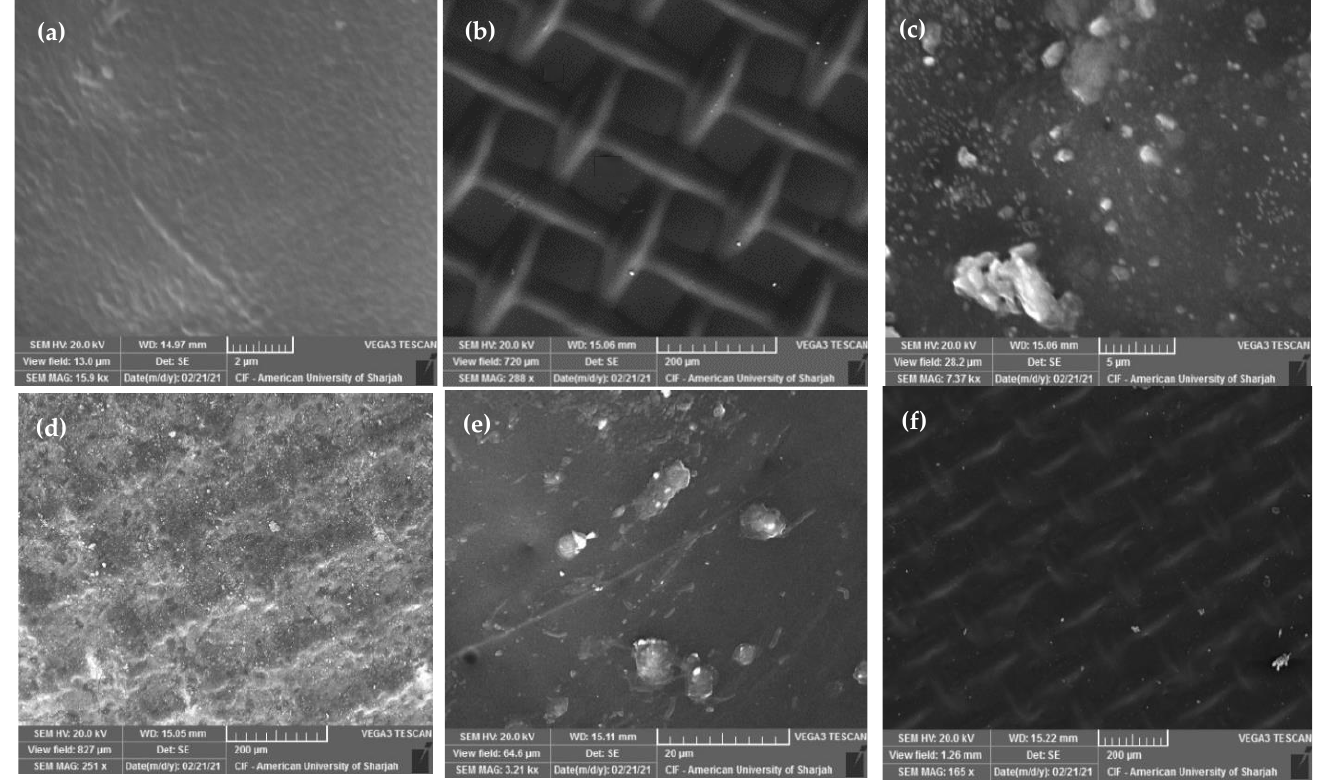
Figure 4. SEM images of the original membrane ( a ) active layer and ( b ) support layer, the membrane after use for the ( c ) active layer and ( d ) support layer at low CFV with the ultrasound facing the support layer (Case 0.25-CC-SL with NaCl draw solution), and the membrane after use for the ( e ) active layer and ( f ) support layer at high CFV with the ultrasound facing the support layer (Case 1.0-CC-AL with MgCl 2 draw solution).